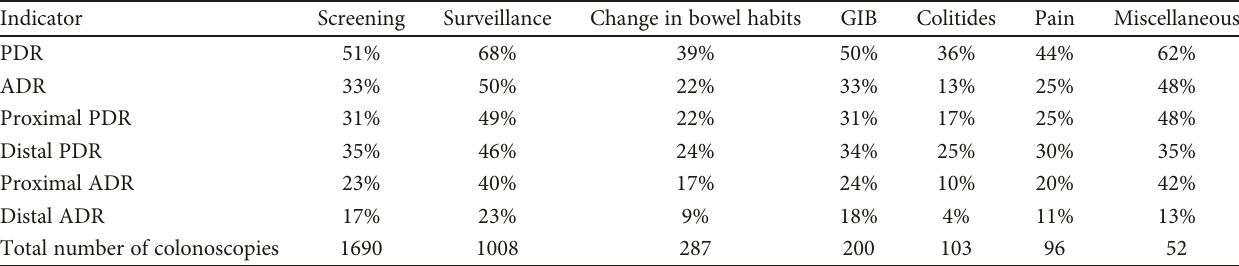
Table 2: Quality indicators by colonoscopy indication.